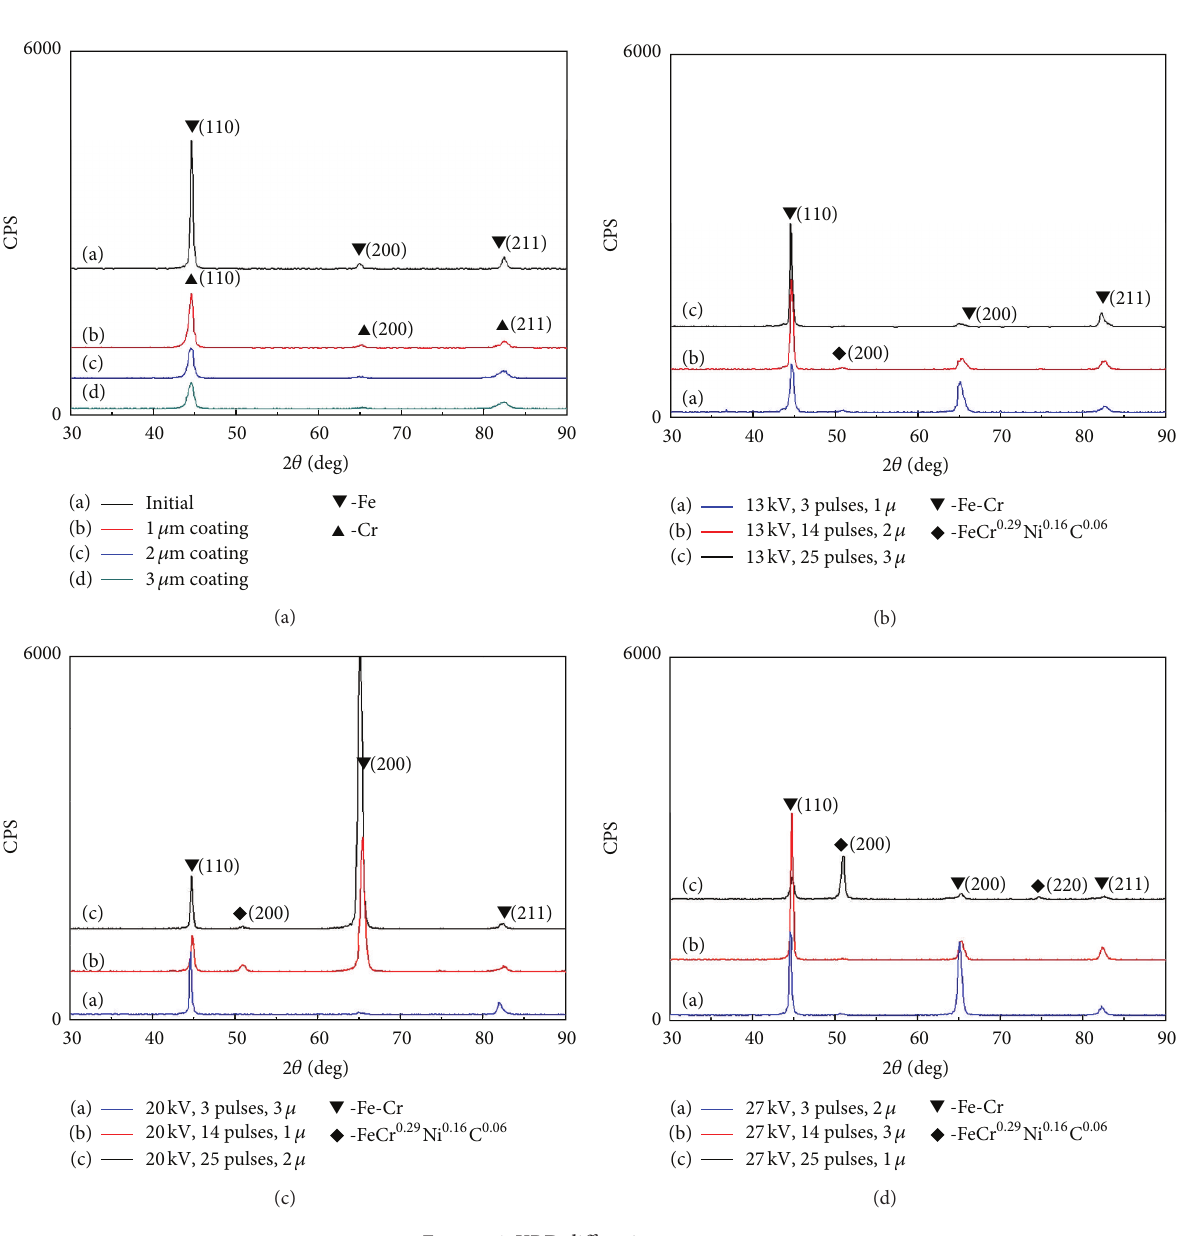
Figure 4: XRD diffraction